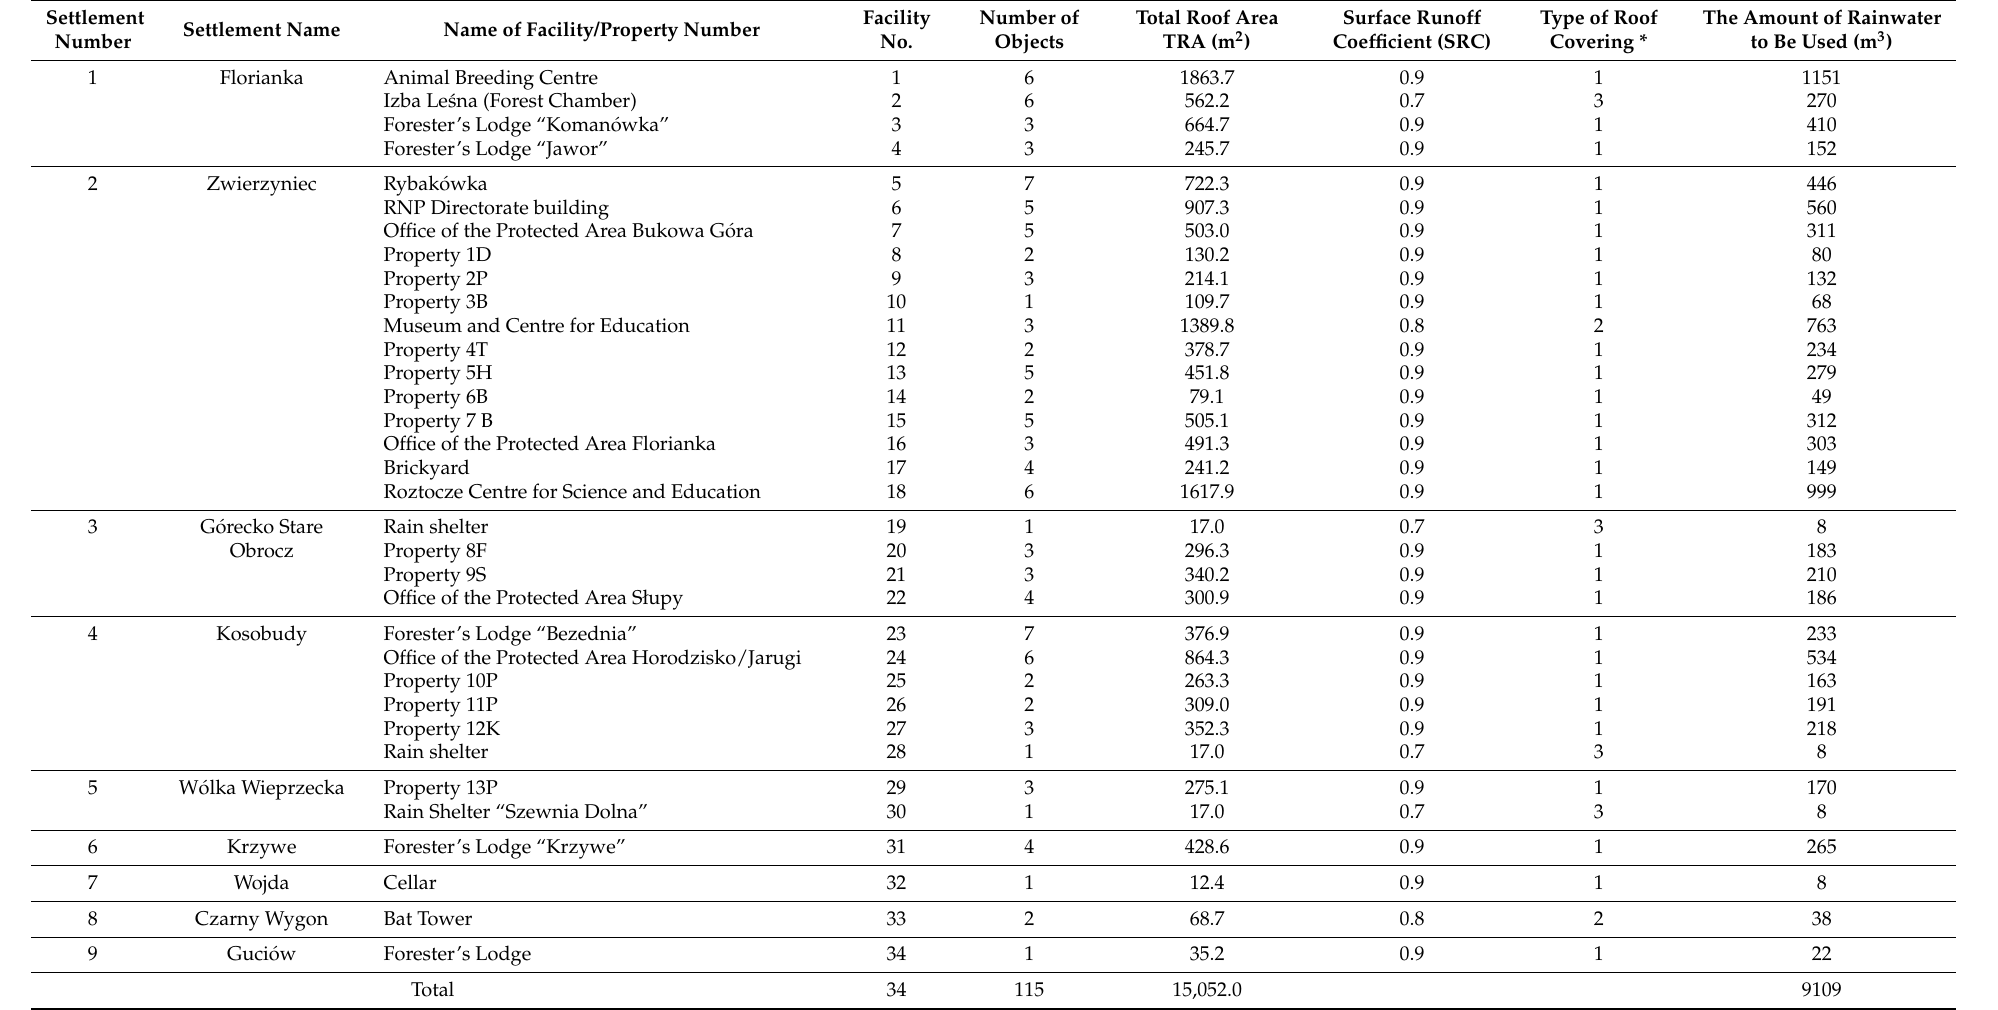
Table 4. Monthly demand for rainwater in the RNP’s Animal Breeding Centre in